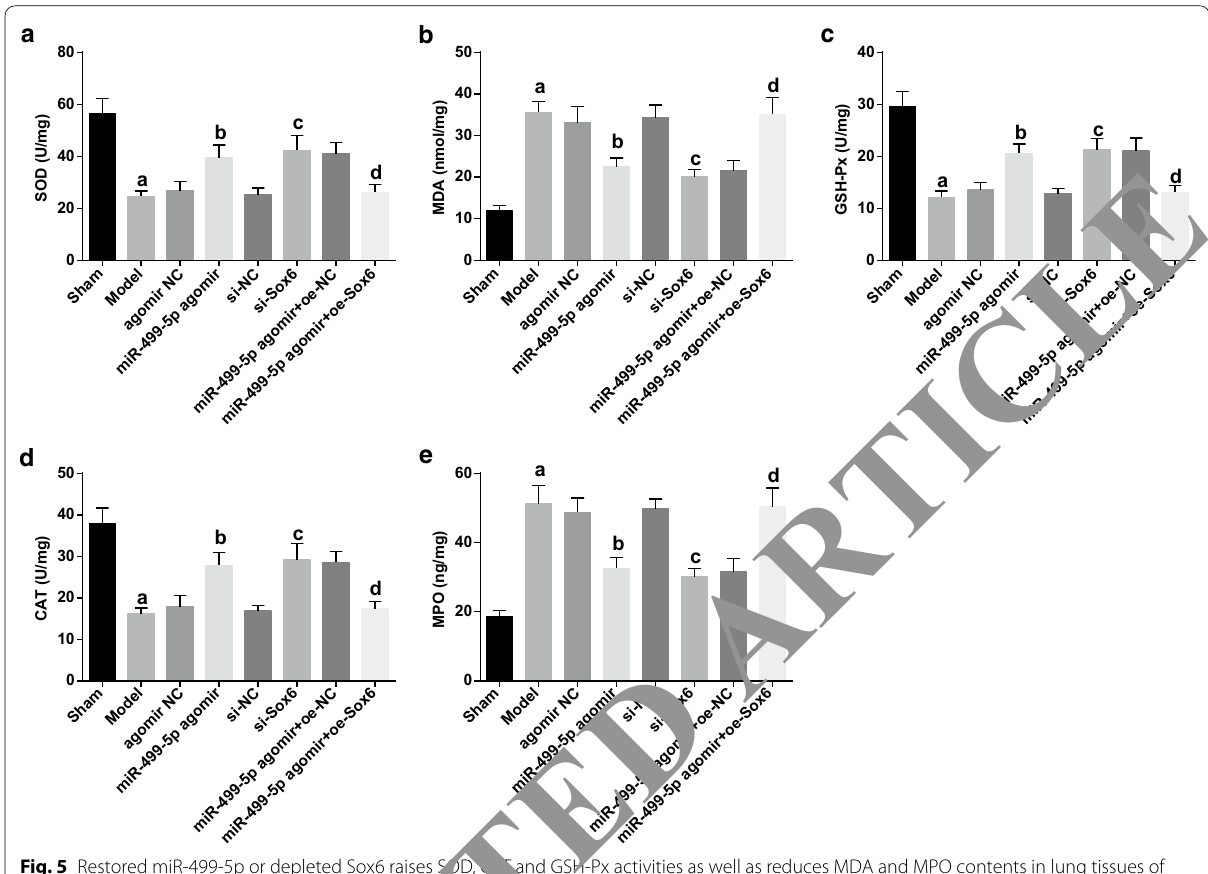
Fig. 5 Restored miR-499-5p or depleted Sox6 raises SOD, CAT and GSH-Px activities as well as reduces MDA and MPO contents in lung tissues of sepsis-induced lung injury mice. a SOD activity in lung tissues of mice. b MDA content in lung tissue of mice. c GSH-Px activity in lung tissues of mice. d CAT activity in lung tissues of each group of mice. e MPO content in lung tissues of mice. (a) P < 0.05 versus the sham group. (b) P < 0.05 versus the agomir NC group. (c) P < 0.05 versus the si-NC group. (d) P < 0.05 versus the miR-499-5p agomir depicted as mean standard deviation, and data were assessed by one-way ANOVA followed by Tukey’s post hoc test ±